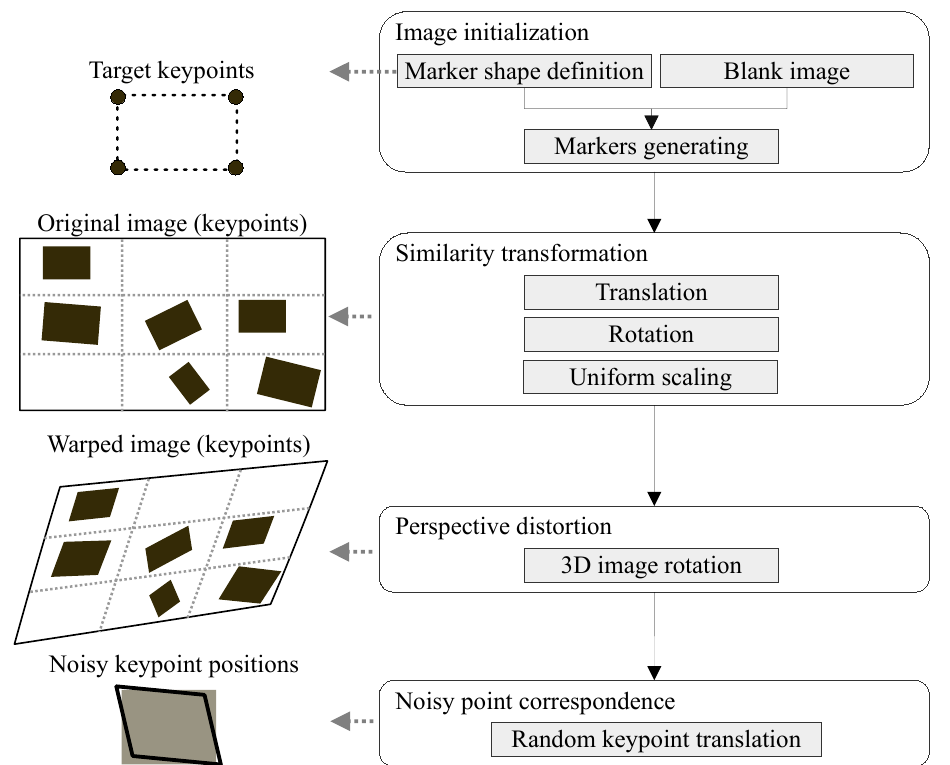
Figure 4. The description of how each one of the t test instances in a specific test scenario is created. The input is a blank w × h image over which m markers are initialized in a uniform grid, which produces the original marker keypoints. Depending on the test scenario, a particular subset of similarity transformations is applied to the entire image. Subsequently, warped keypoints are modified by random noise to simulate noisy point